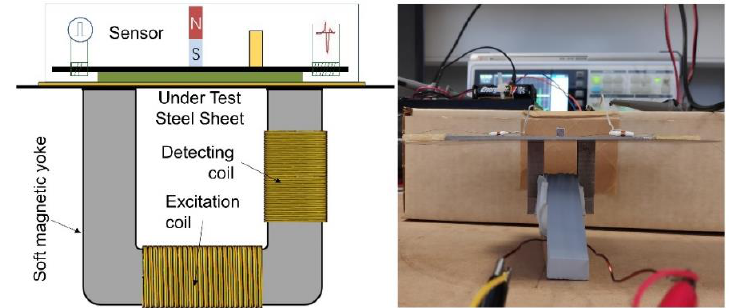
Figure 8. The schematic and photo of the calibration of the sensors with respect to permeability of the under-test steel, determined by the current transmitted to the excitation coil and monitored by the secondary coil of the Π shaped 7 ppm carbon soft iron electromagnetic yoke.